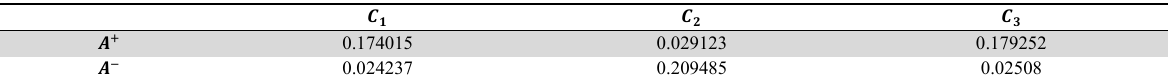
The TOPSIS positive and negative ideals